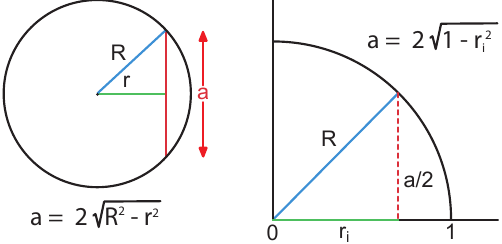
Figure B1. Model to generate apparent random sections through a sphere to calculate the apparent diameter. Following the Pythagorean theorem, it is necessary to know the radius ( R) and the apothem ( r) to calculate the chord or section length through a sphere. Taking a sphere of radius 1, the first random apothems ( r i ) between 0 and 1 are generated and then the apparent diameters (from 2 to 0) are calculated and